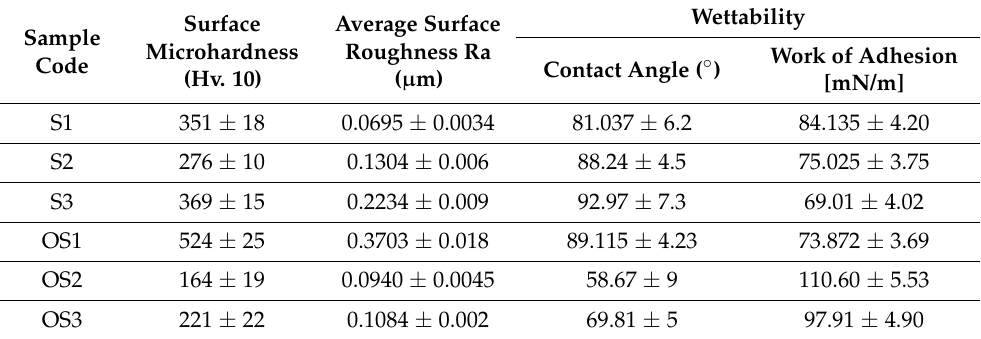
Table 3. Surface microhardness, average surface roughness, and wettability for the stainless steel grades, before and after the heat ‐ treatment process.